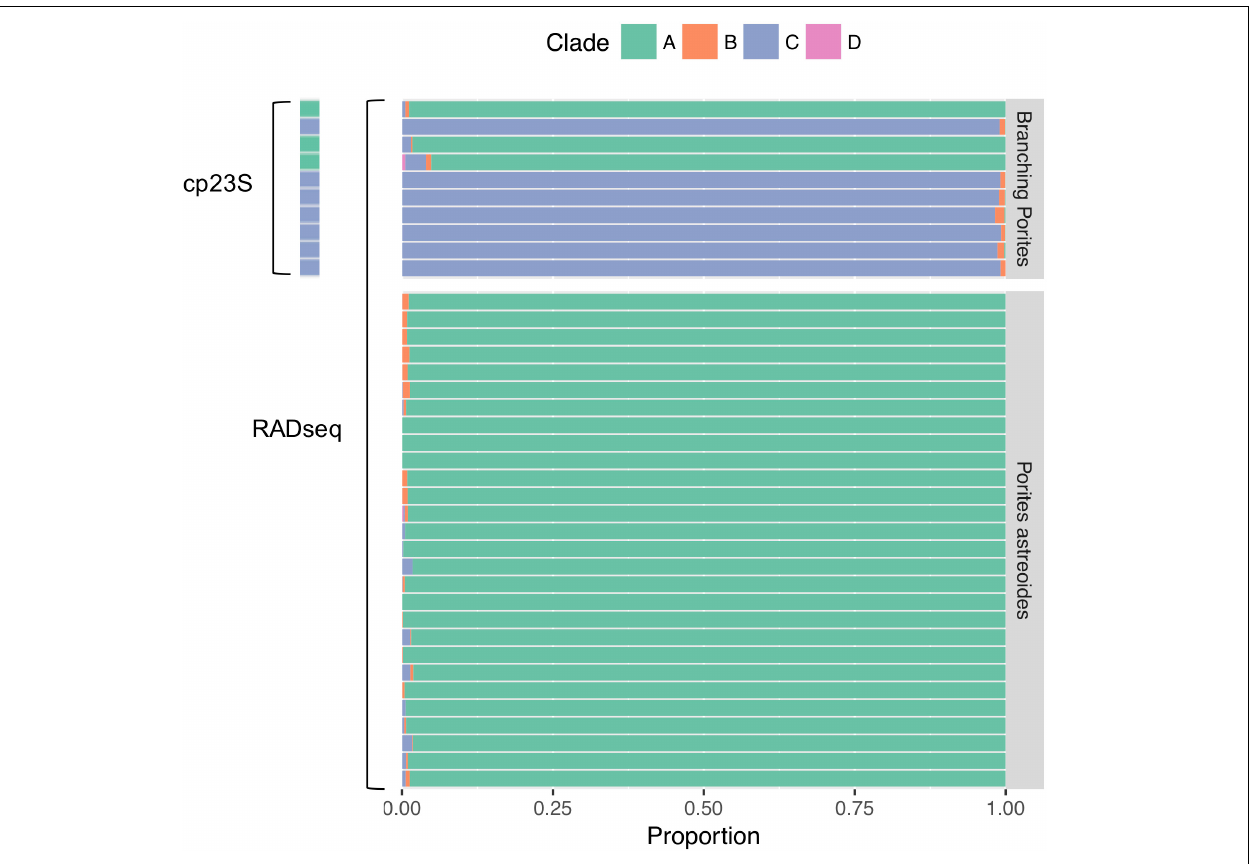
FIGURE 2 | Symbiont identification using BLAST searches of ddRADseq data against custom databases of Symbiodinium (formerly Symbiodinium clade A), Breviolum ( Symbiodinium clade B), Cladocopium ( Symbiodinium clade C), and Durusdinium ( Symbiodinium clade D). Top panel shows symbionts of branching Porites spp. collected for a prior study (Dimond et al., 2017); the dominant symbiont found in BLAST searches was identical to the dominant symbiont identified via cp23S Sanger sequencing. Bottom panel shows results from analysis of the P. astreoides colonies that are the primary subject of this